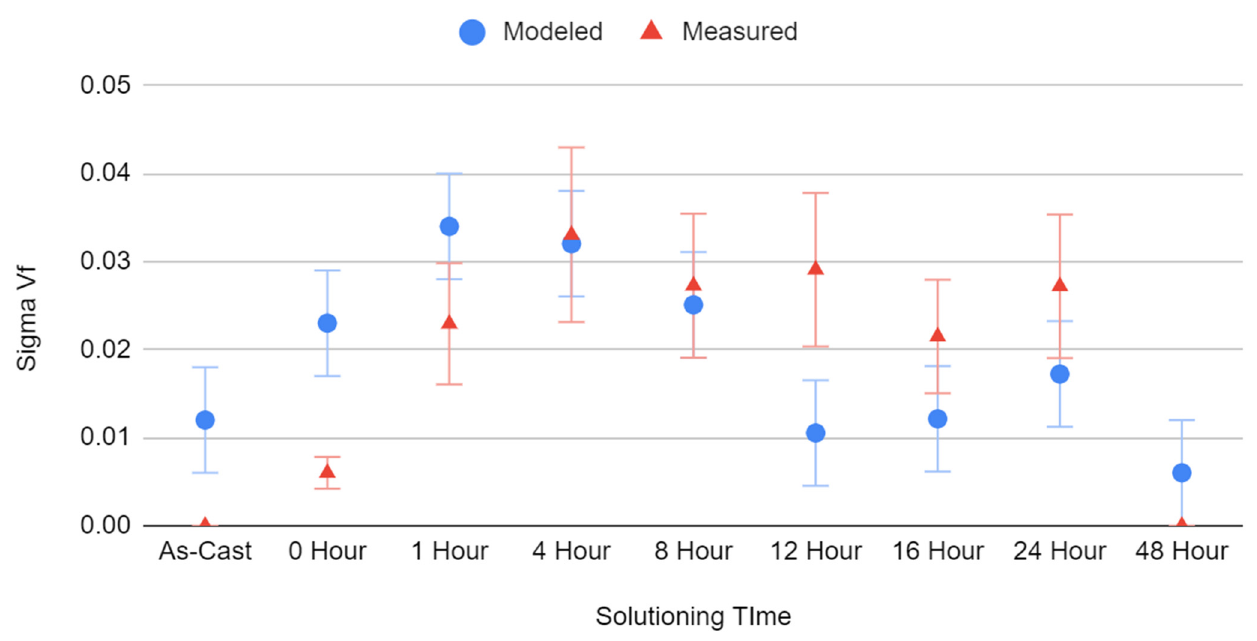
Figure 6. The calculated values of σ phase volume fraction (Vf) using different methods for CMSX-10N.